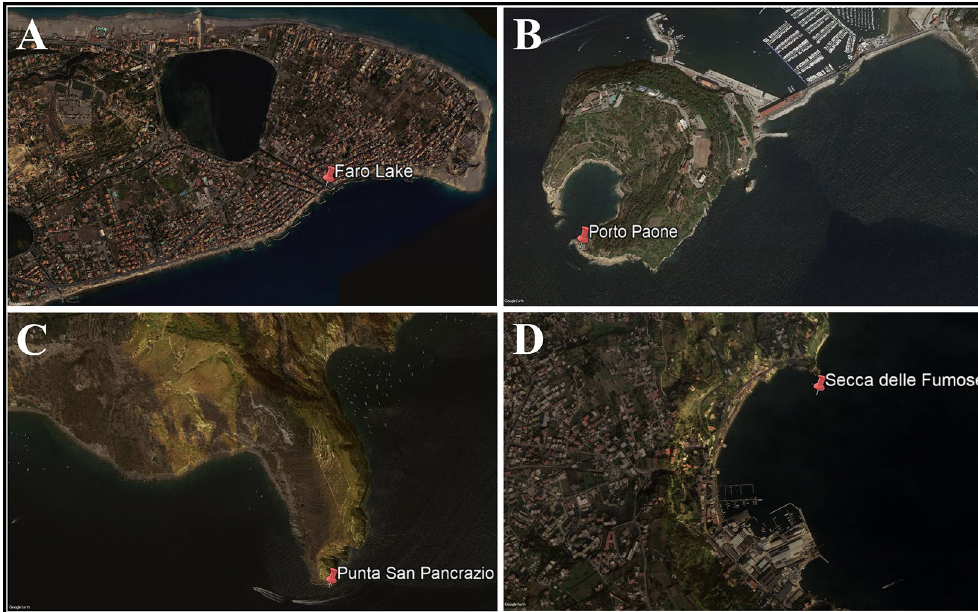
Figure 5. Sampling sites of sponge species collected in Faro Lake (Messina, A ), Porto Paone ( B ), Punta San Pancrazio ( C ) and Secca delle fumose ( D ). Picture was created by Google Earth